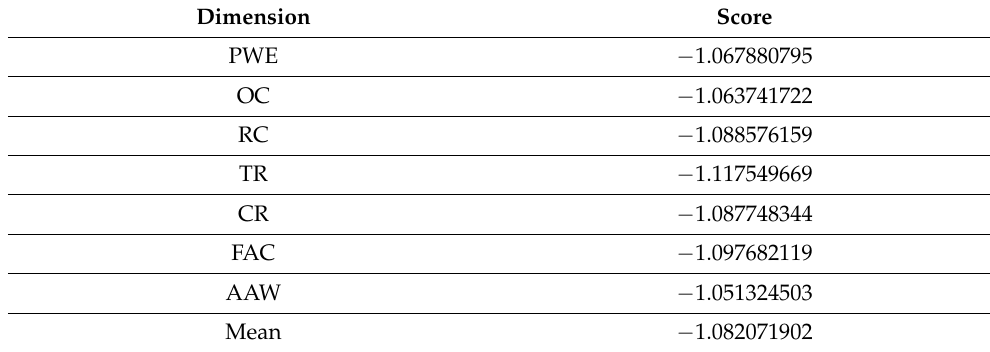
Table 6. Unweighted gap scores.